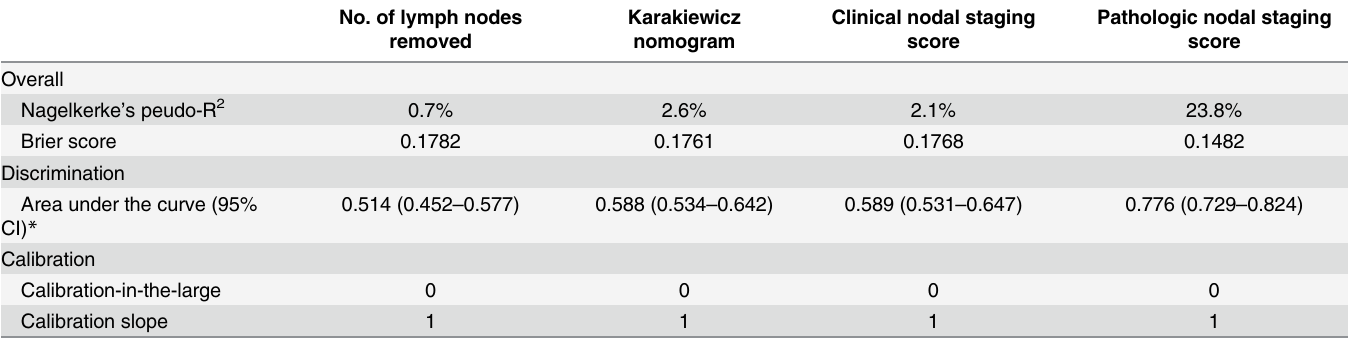
Data of model performances are presented in Table 3. pNSS demonstrated good predictive effi- cacy. Estimates of Nagelkerke ’ s peudo-R 2 of pNSS were higher than those of others. The brier score of pNSS was 0.1482, which was lower than that of other models. Table 3. Performance of